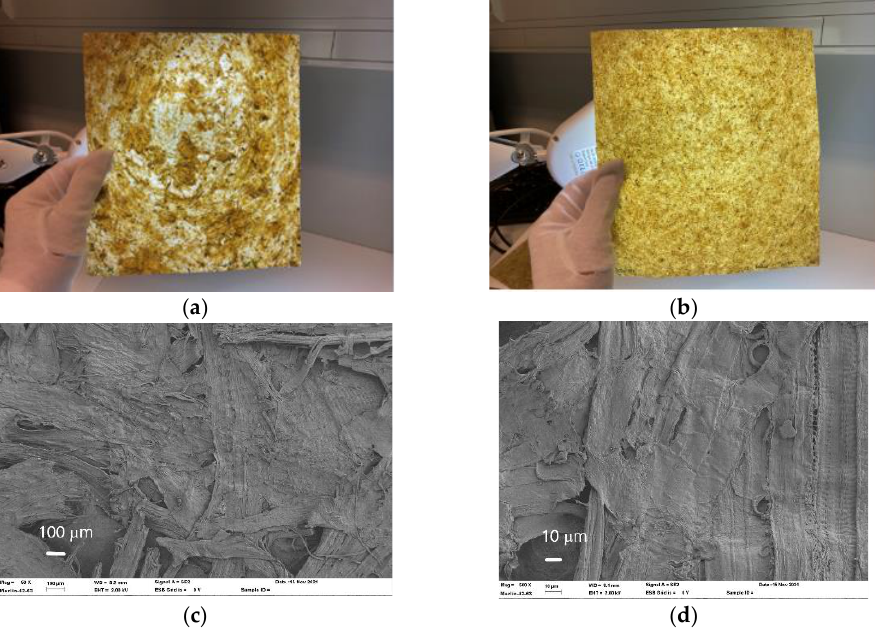
Figure 5. ( a ) Sample made with rough oat fibers (Oat, 80 °C, 60 min, NaOH 12) viewed against backlight; ( b ) sample made with the refined quality of the same fibers; ( c , d ) Hot pressing improves bonding and closes a part of the sample surface, as shown in the SEM images of the sample obtained from unrefined Oat 12/80 (Table 3). Table 4. Properties of sheets made from unrefined (unref.) and refined straw. For the refined Oat 12/80 trial point, also data with a special enzyme treatment and 30-min hot pressing are included. Wet strength was measured after 1 h of water immersion.